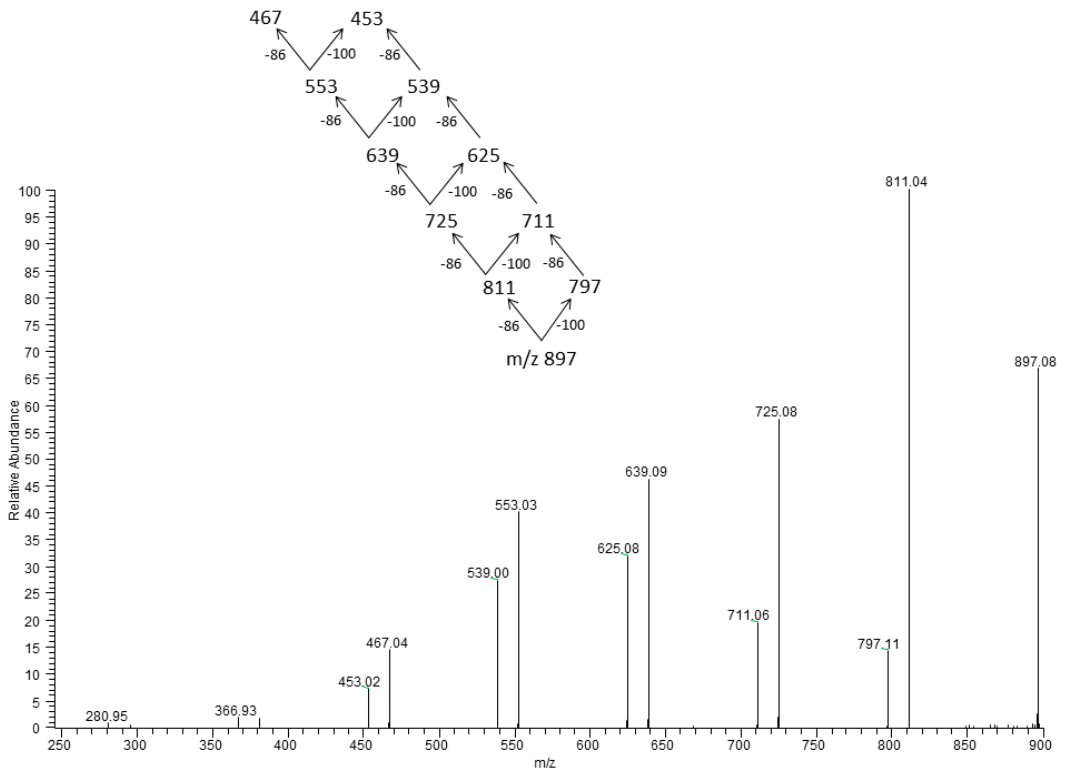
Figure 6. ESI-MS/MS spectrum obtained for the selected sodium adduct of oligomers [HB 9 HV + Na] + at m / z 897.